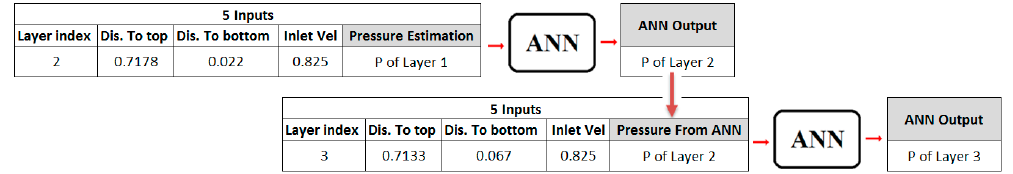
Figure 37. Detail of cascading deployment for average gas pressure using five parameters when information flows from upstream to downstream.